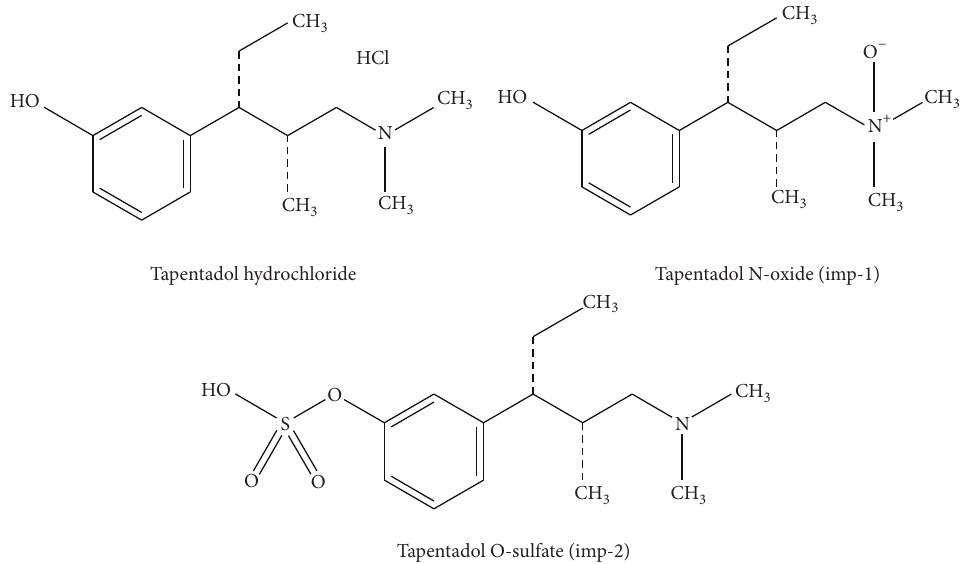
F 1: Structure of tapentadol and its process-related